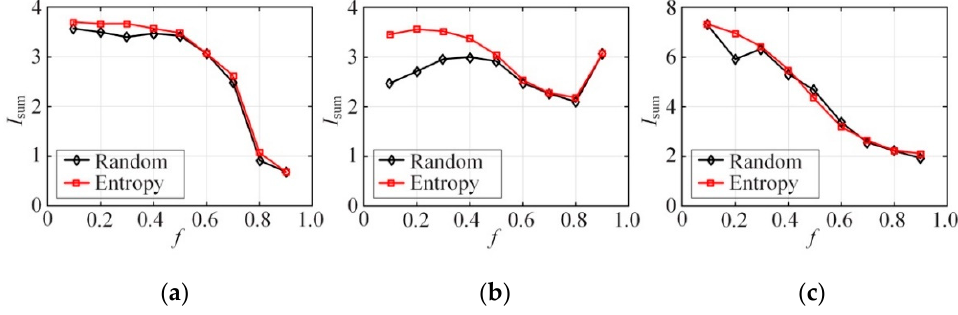
Figure 6. Mutual information 𝐼 sum (synthetic dataset) vs. f (k = 2): ( a ) NLTCS, ( b ) Adults, ( c ) TPC-E.